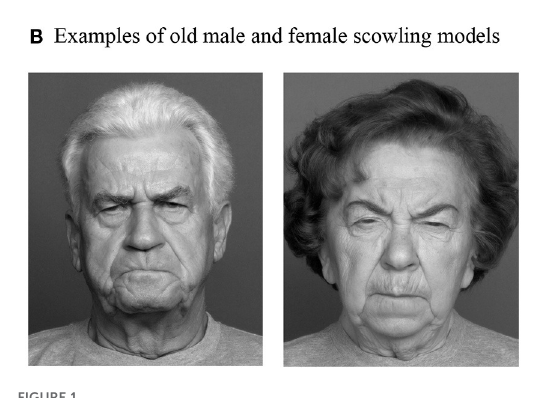
FIGURE1 Facial photographs (Ebner et al., 2010) the Center for Lifespan Psychology, Max Planck Institute for Human Development, Berlin, Germany. Used with permission from the Max Planck Institute. These models are examples of images used in this study and not the actual images used. (A) Examples of young male and female scowling models. (B) Examples of old male and female scowling